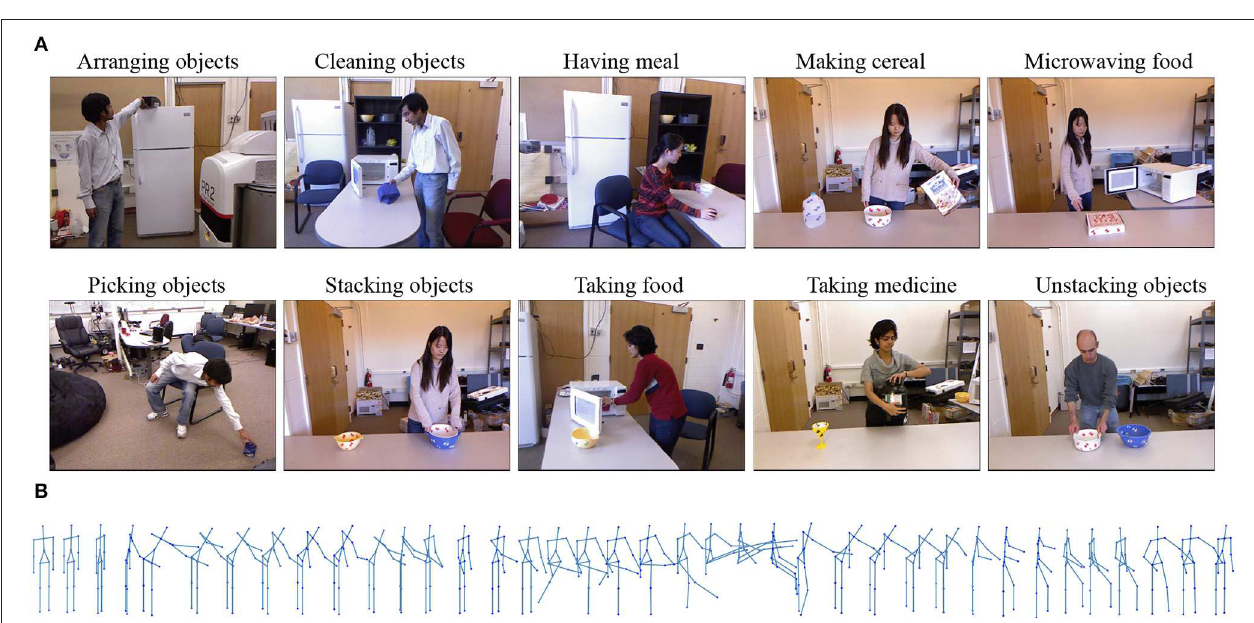
FIGURE 3 | An experiment with a 2D dataset of two nested clusters demonstrates the effects of learning with a standard GWR network (first row) compared to the new neuron insertion strategy (second row) ( Mici, 2018). The first plot of both rows shows the neuron placement after a complete training, the second plot shows the class-specific neural growth during each learning iteration, and the third shows the classification error measured every 100 iterations.